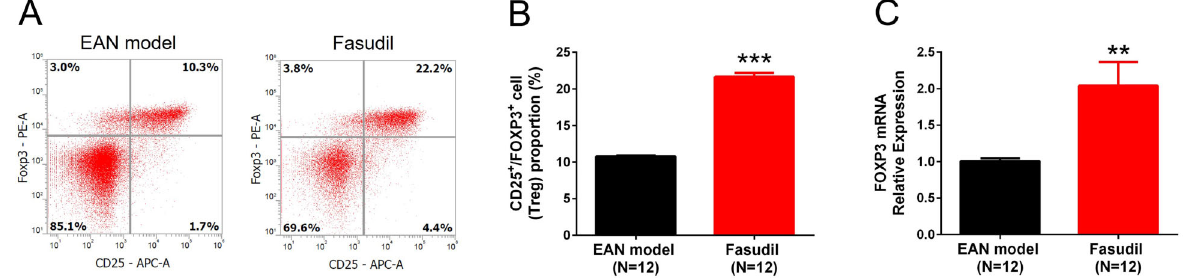
Figure 6. Tregs proportion in splenocytes after induction of experimental autoimmune neuritis (EAN). Fasudil increased CD25 + FOXP3 + cell proportion ( A and B ) and FOXP3 mRNA expression ( C ) in splenocytes at day 28. Data are reported as mean and SD. **P o 0.01, ***P o 0.001 ( t